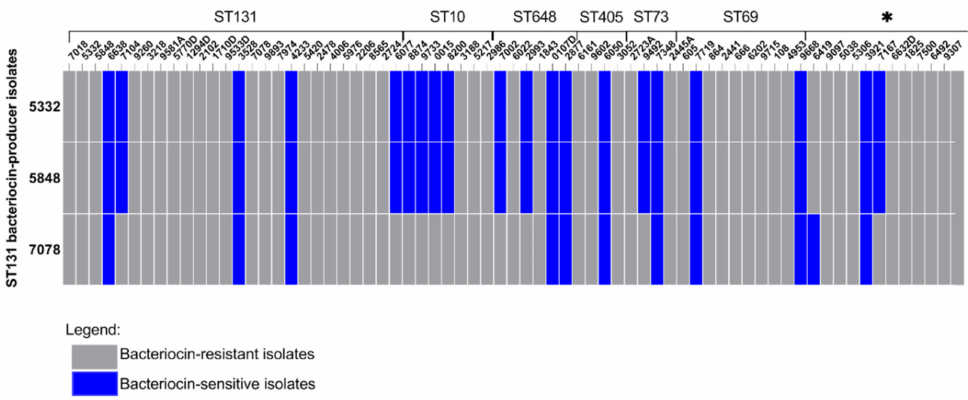
Figure 1. Bacteriocin activity among ST131. The graph shows the bacteriocin activity of the three bacteriocin-producer ST131 isolates against other isolates that belong to ST131, ST10, ST648, ST405, ST73, ST69, ST297 and ST414. The * indicates the singleton isolates. The dark blue hits indicate the isolates that were sensitive to bacteriocin and the grey hits indicate bacteriocin-resistant